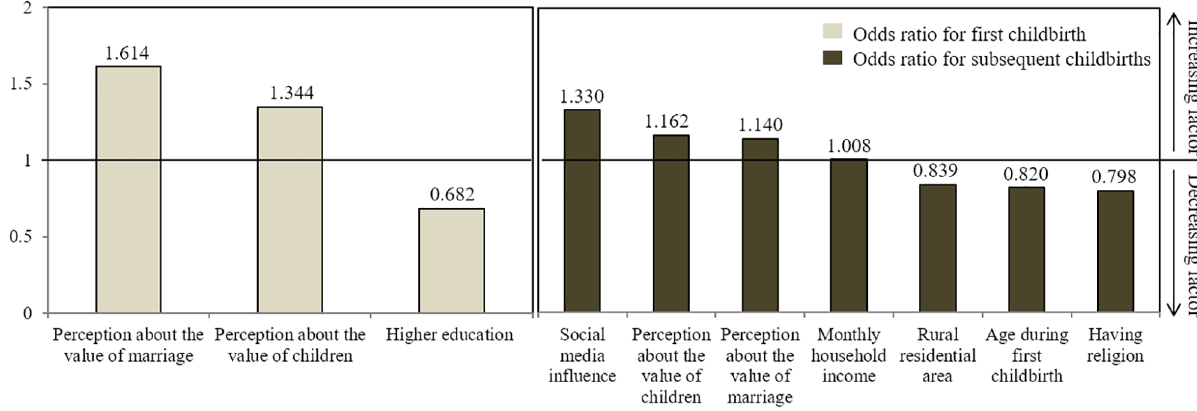
Fig 1. Comparison of influencing factors and odds ratios for women’s first and subsequent